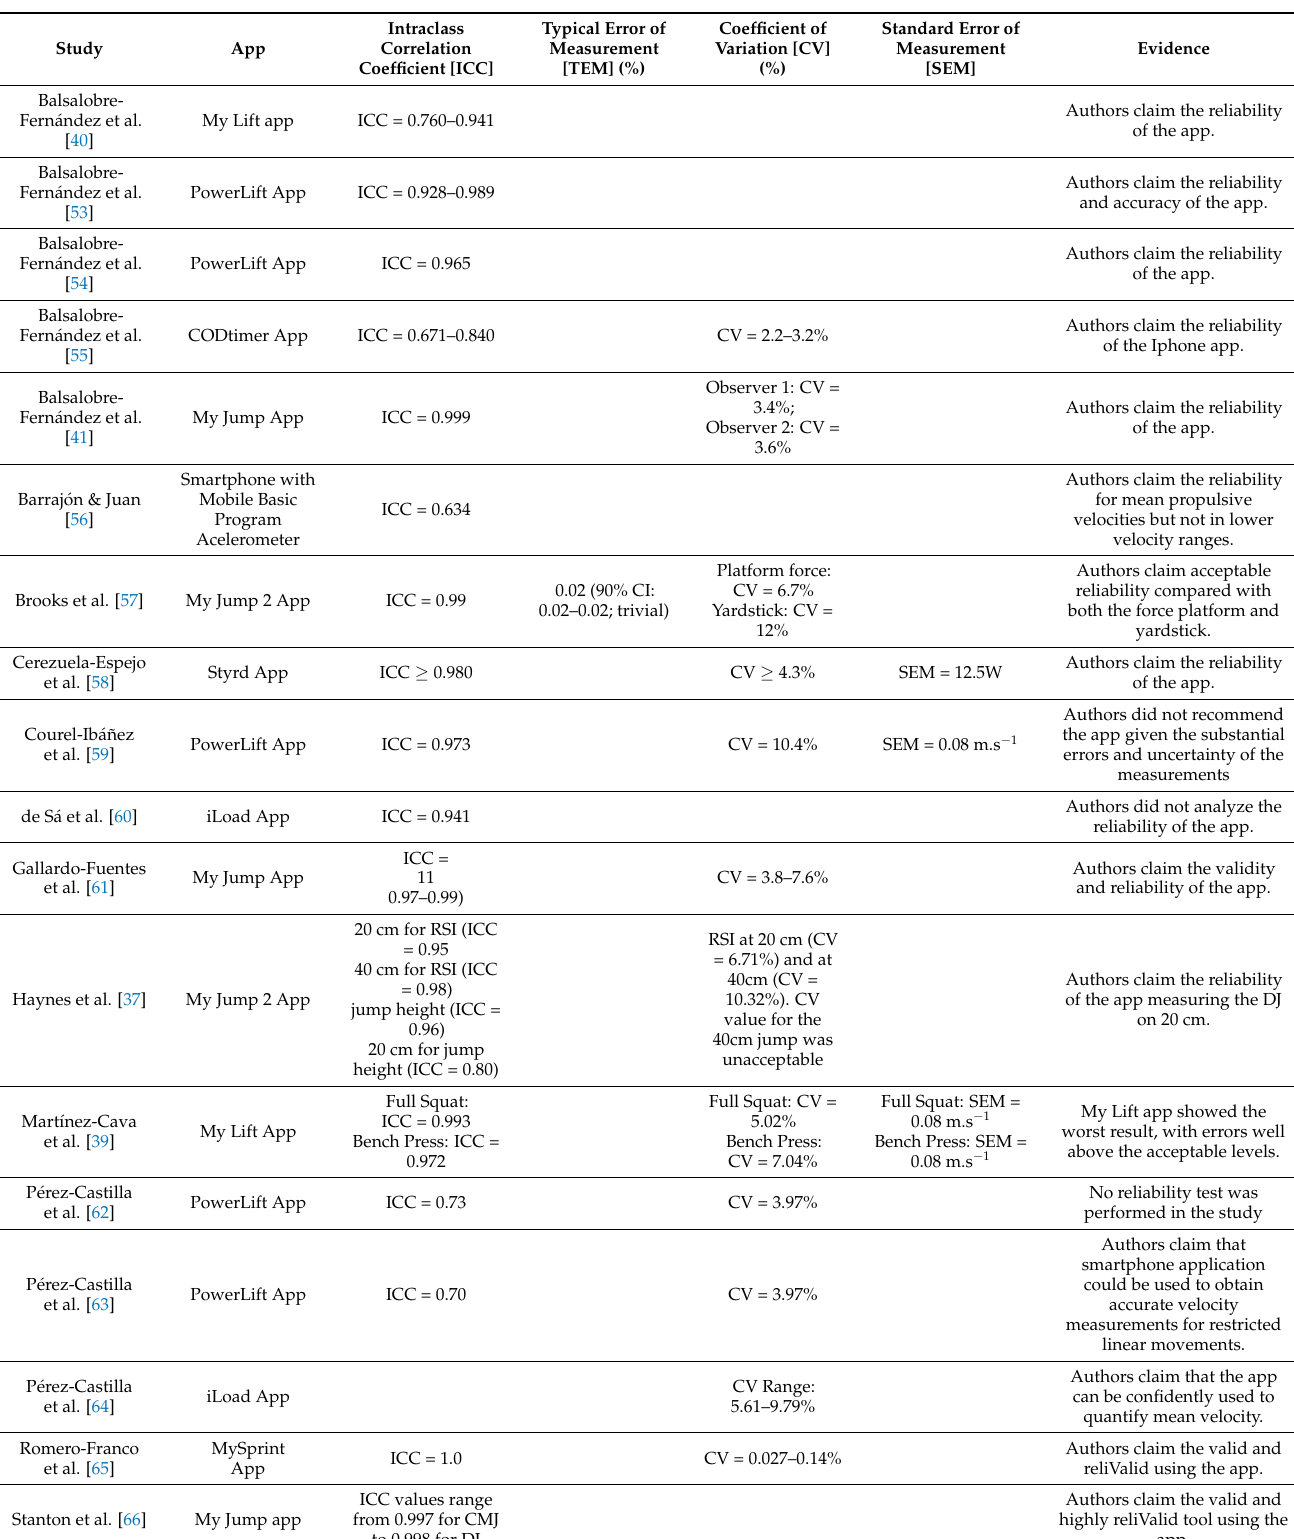
Table 5. Reliability of apps for estimation of movement velocity, movement time and movement